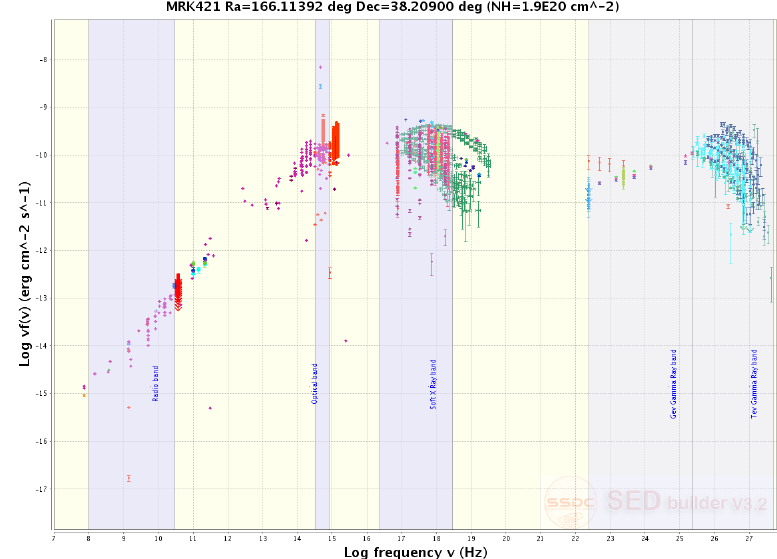
Figure 1. Spectral energy distribution of Mrk421, showing the two typical spectral components, and variability, generated using https://tools.ssdc.asi.it/SED, data from